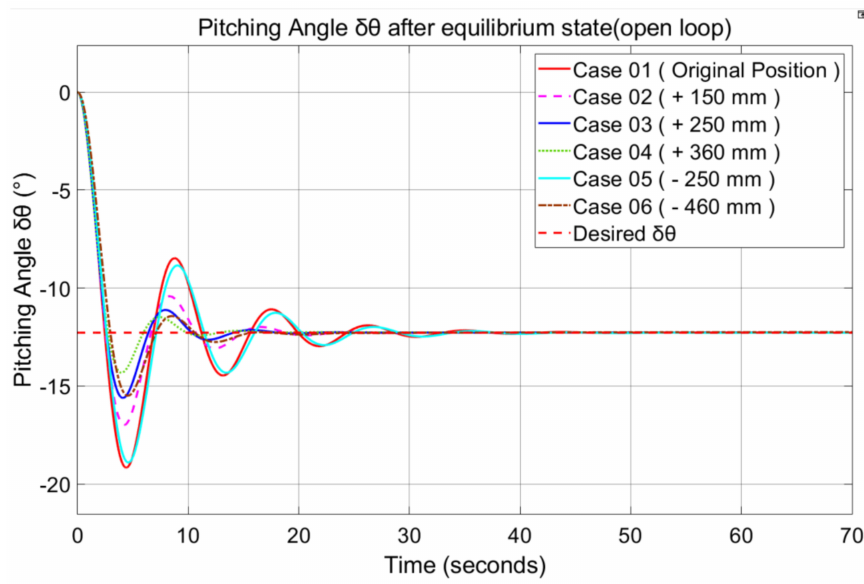
Figure 18. Responses of the pitching Angle ( δθ ) (open